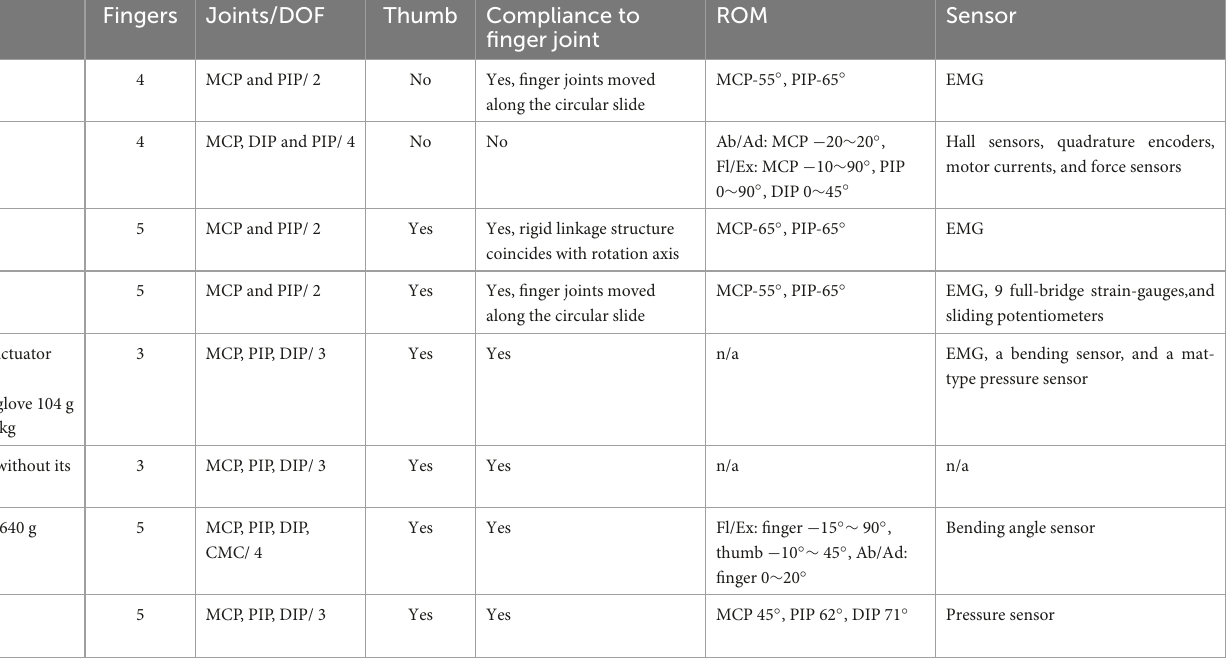
TABLE 1 Characteristics of hand